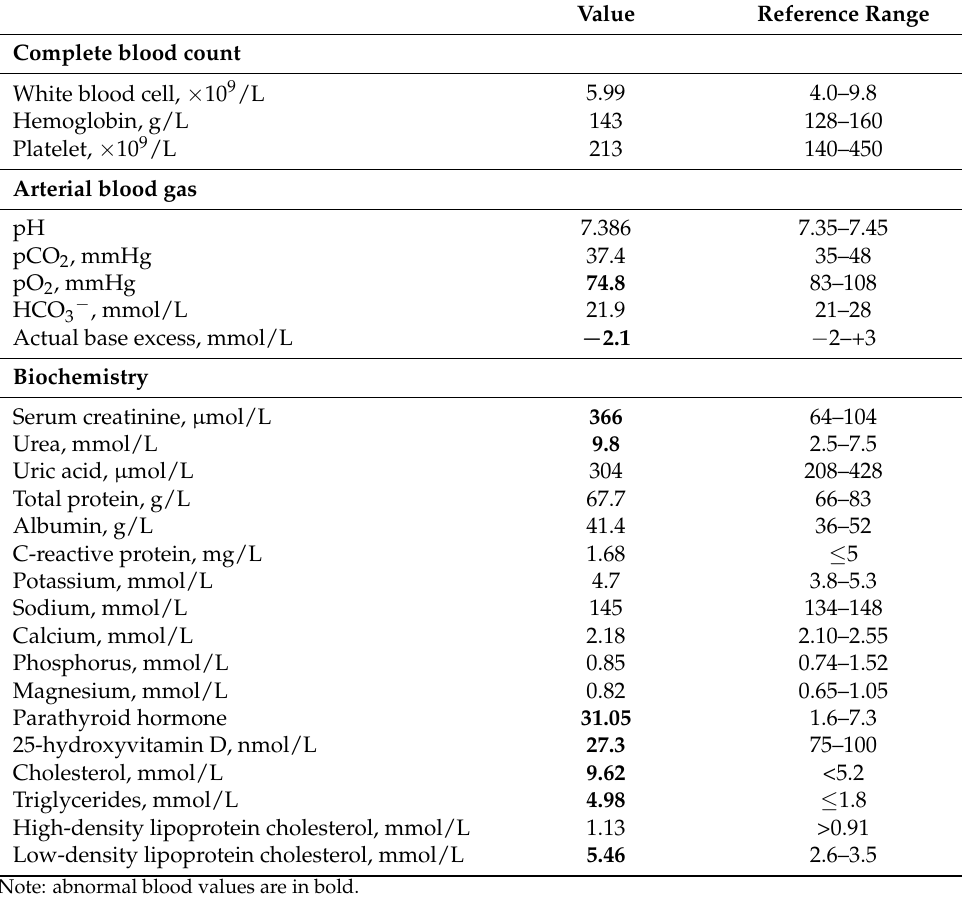
Table 1. Laboratory investigation.